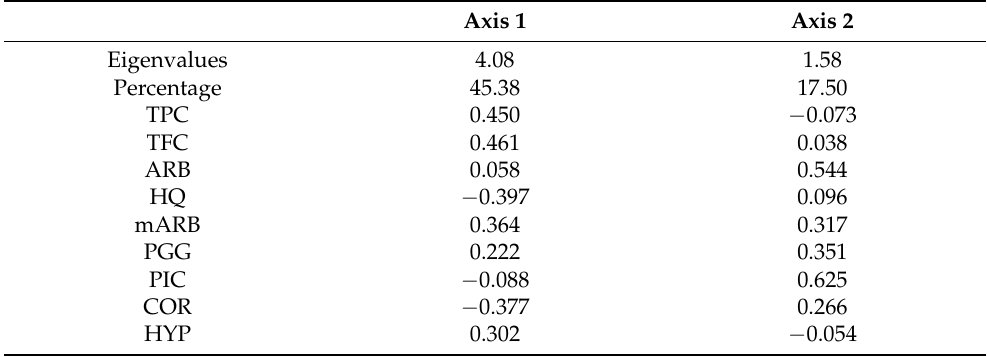
Table 1. Results of PCA based on the secondary metabolite composition of water and